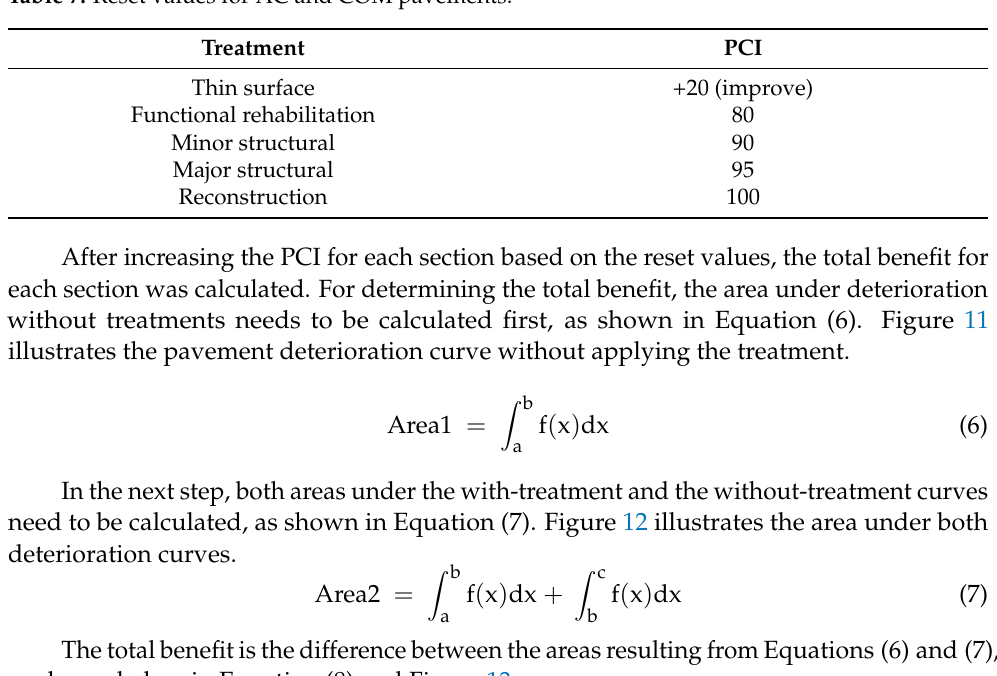
Table 7. Reset values for AC and COM